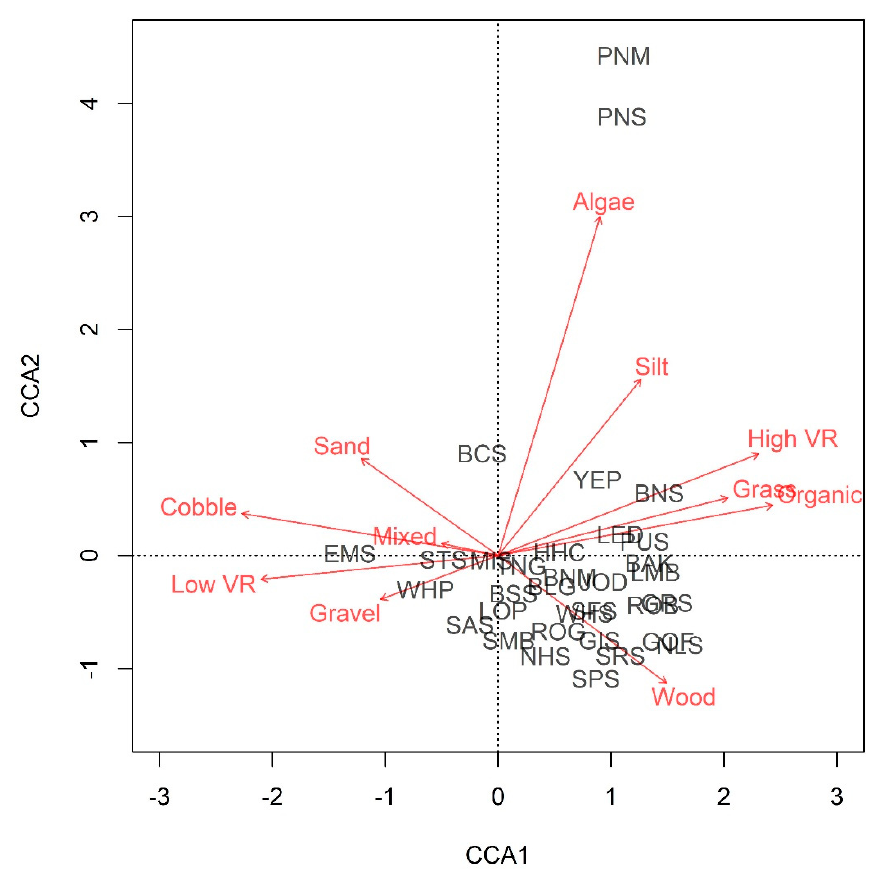
Figure 6. The first two axes from a canonical correspondence analysis examining fish species–habitat associations. Labels for arrows indicate in-river substrate types, aquatic macrophyte richness (‘Low VR’ = low macrophyte richness and ‘High VR’ = high macrophyte richness), or shoreline vegetation types (‘Grass’, ‘Mixed’, and ‘Wood’). Three-letter codes indicate species: BAK = banded killifish, BCS = blackchin shiner, BLG = bluegill, BNM = bluntnose minnow, BNS = blacknose shiner, BSS = brook silverside, EMS = emerald shiner, GIS = gizzard shad, GOF = goldfish, GRS = green sunfish, HHC = hornyhead chub, JOD = Johnny darter, LED = least darter, LMB = largemouth bass, LOP = logperch, MIS = mimic shiner, NHS = Northern hogsucker, NLS = northern sunfish, PNM = pugnose minnow, PNS = pugnose shiner, PUS = pumpkinseed, ROB = rock bass, ROG = round goby, SAS = sand shiner, SFS = spotfin shiner, SMB = smallmouth bass, SPS = spotted sucker, SRS = striped shiner, STS = spottail shiner, TNG = tubenose goby, WHP = white perch, WHS = white sucker, and YEP = yellow perch. Scientific names for species are provided in Table S1.